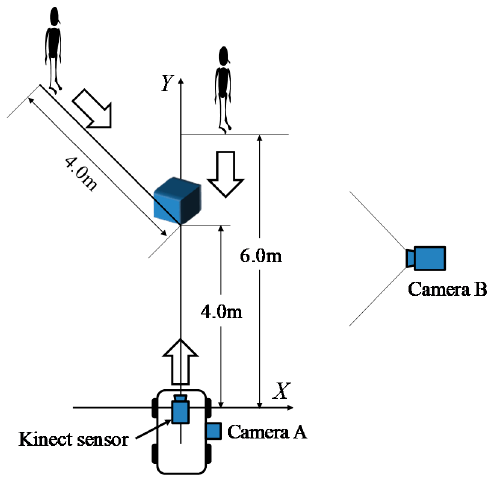
Figure 8. Experimental methodology.